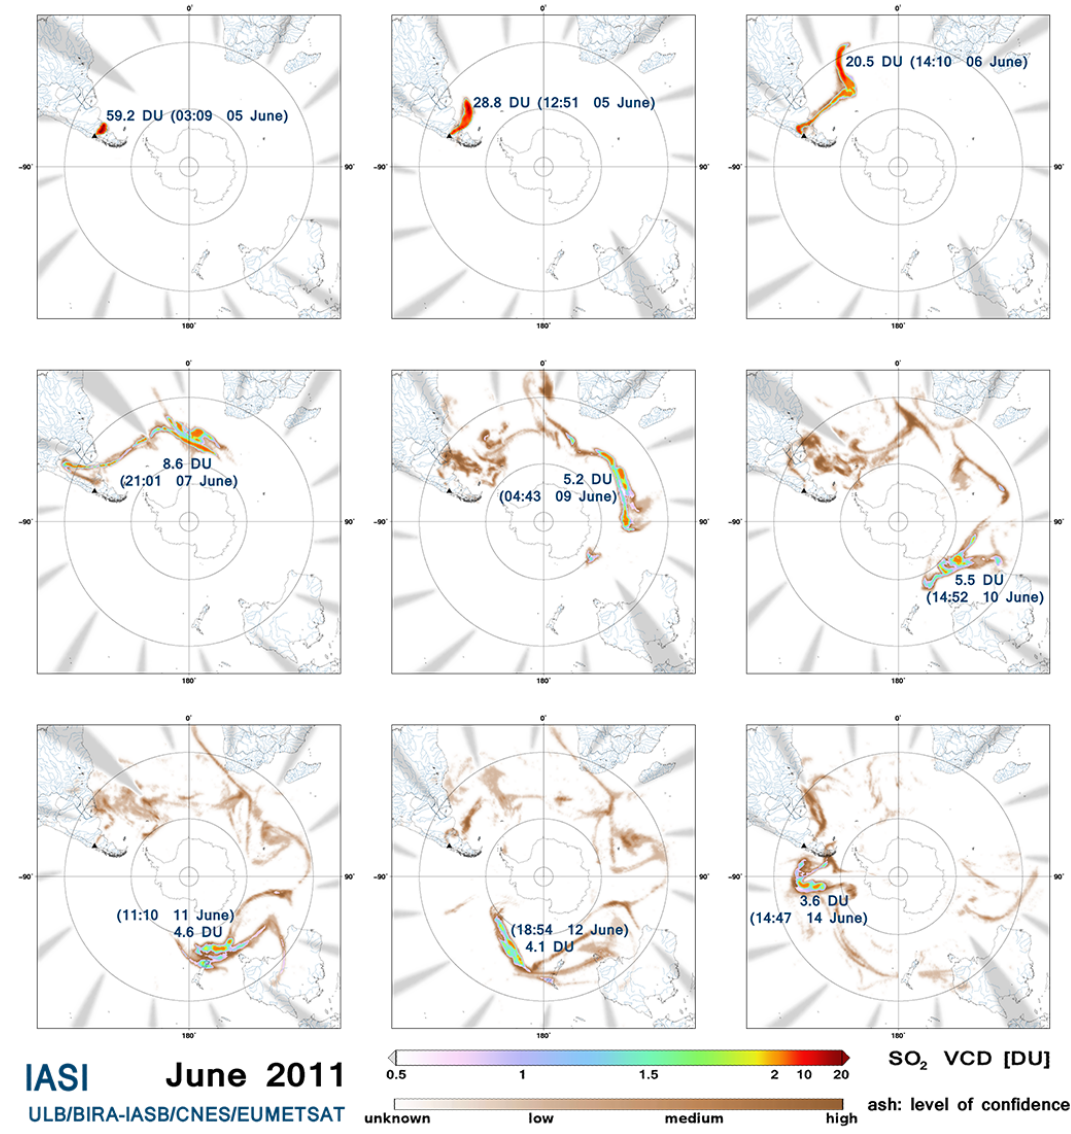
Fig. 22. SO 2 and ash detected by IASI-A (Puyehue-Cordón Caulle eruption, 6 June 2011).